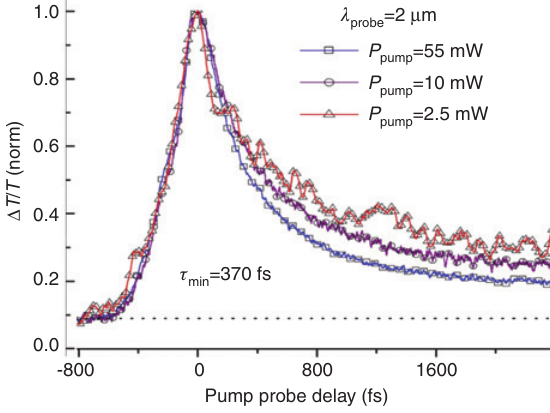
Figure 7: Typical plot of transmission as a function on adjustable time delay [196].